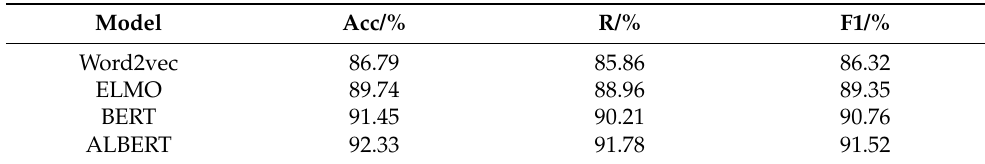
Table 4. Contrasting various word vector